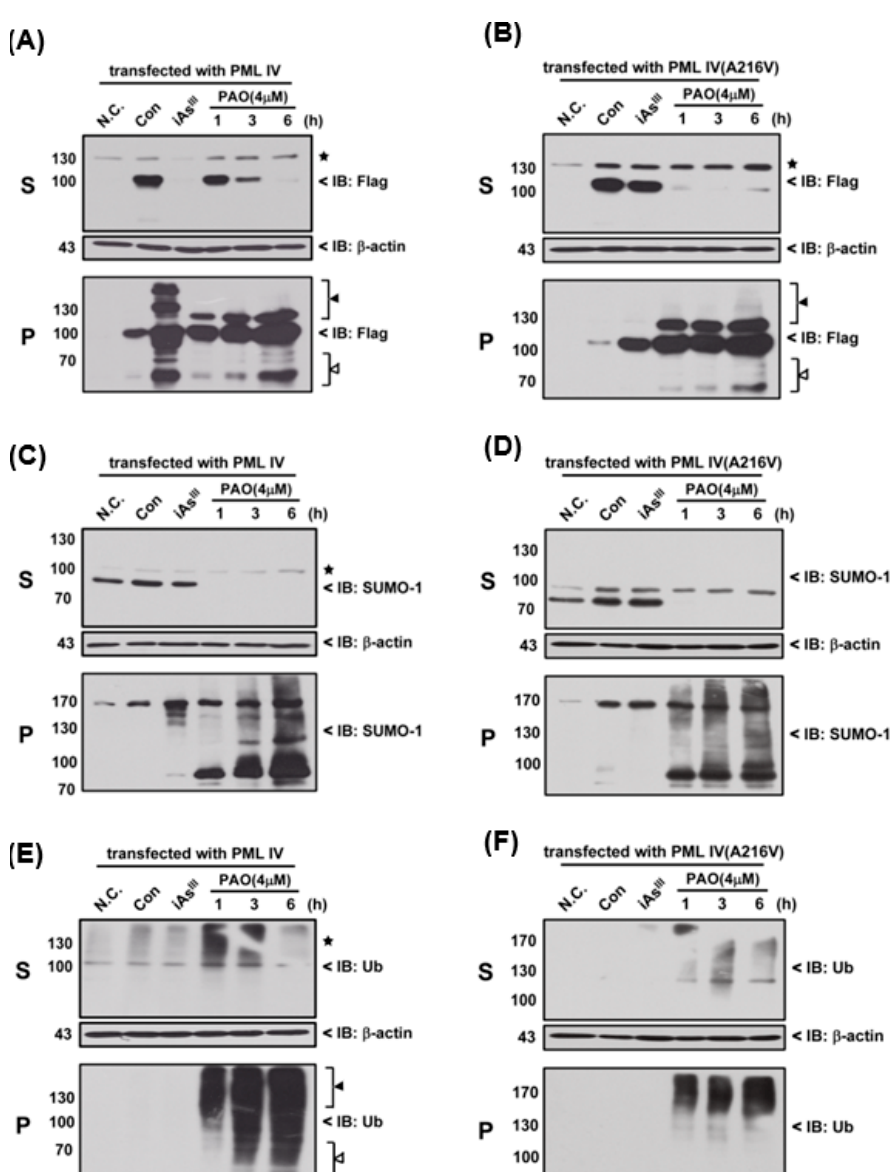
Figure 4. Effects of PAO on induction of SUMOylation and ubiquitination. Flag-PML-IV or PML-IV (A216V) over-expressed HEK293T cells were treated with 4 µM iAs III for 6 h or PAO at indicated time points (1, 3 and 6 h) to determine the PML-IV ( A ); and PML-IV (A216V) ( B ) protein solubility changes; SUMOylation ( C , D ); and ubiquitination ( E , F ). The star ( ★ ) indicates non-specific protein bands, the white triangle ( △ ) indicates the protein degradation and black triangle ( ▲ ) indicates protein modification. SUMOylation and ubiquitination of PML protein in supernatant and pellet fractions were detected using anti-SUMO-1 and anti-Ub primary antibodies, respectively. In fact, PAO is a protein phosphatase inhibitor [24] and contains a phenyl group. Thus, we hypothesized that inhibition of protein phosphatase activity or phenyl group of PAO may be involved in PML protein solubility changes. Therefore, three different chemical compounds such as phenylarsine oxide (PAO), okadaic acid (OA; inhibitor of protein phosphatase) and nitrosobenzene (NB; contain phenyl group) were used to compare the PML-IV or mutant PML (A216V) protein solubility change, as shown in Fgiure 5A. Unexpectedly, OA and NB have no considerable effects on